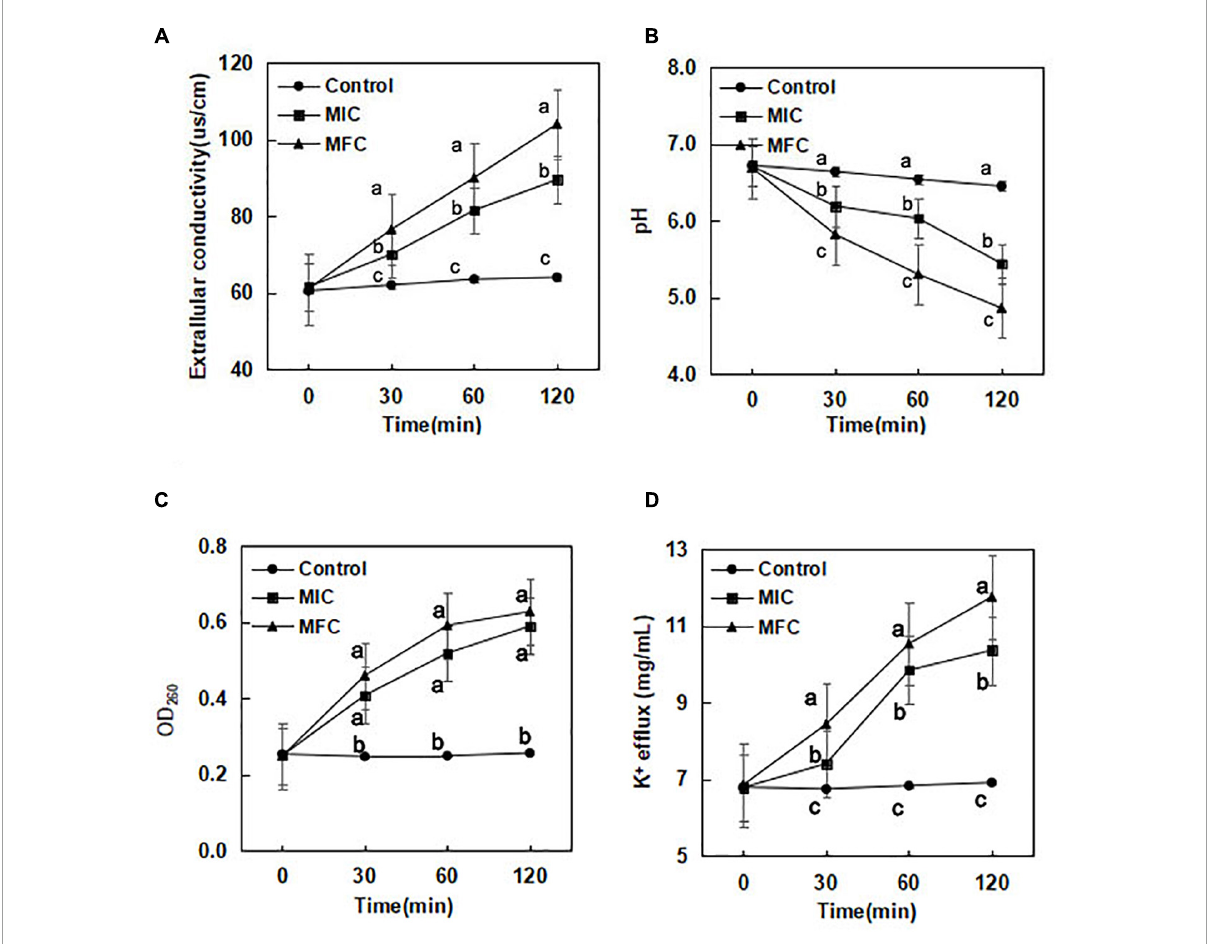
FIGURE1 Effect of ( E )-2-hexenal on extracellular conductivity (A) , extracellular pH (B) , 260 nm absorbing material release (C) , and K + efflux (D) of B. cinerea [( (cid:4) ):1 × MIC; ( (cid:4) ):1 × MFC; ( • ): control]. Data presented are the means of pooled data. Error bars indicate the SDs of the means ( n = 6). Symbols with different letters at each time point indicate significant differences according to Duncan’s multiple range test ( p < 0.05).